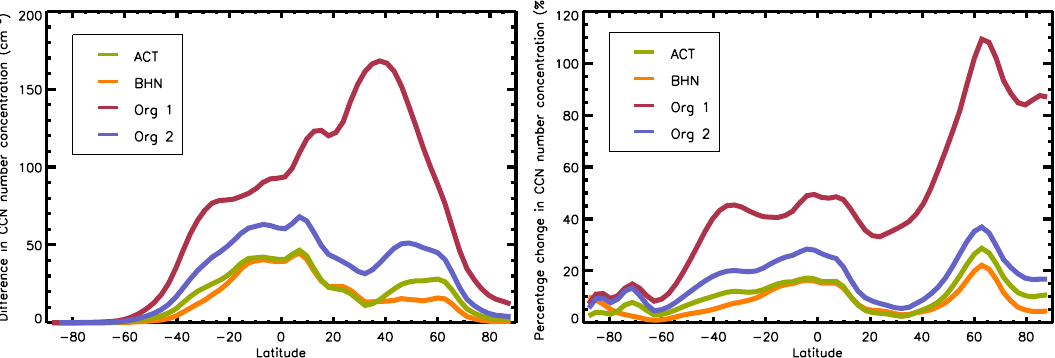
Fig. 3. Annual mean absolute change in surface CCN number concentration (left) and percentage change (right) at 0.2% supersaturation for four particle formation mechanisms: ACT (green), BHN only (orange), Org1 (red) and Org2 (blue) from the emission of monoterpenes